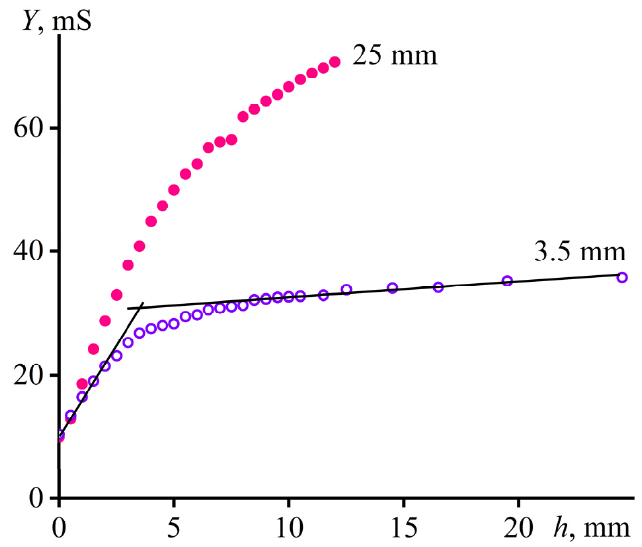
Figure 5. Dependences of the admittance of a cell with saturated NaCl solution on the depth of immersion of a carbon bundle. Another electrode was the bundle, whose depth of immersion is shown near the curves; AC frequency: 120 Hz.